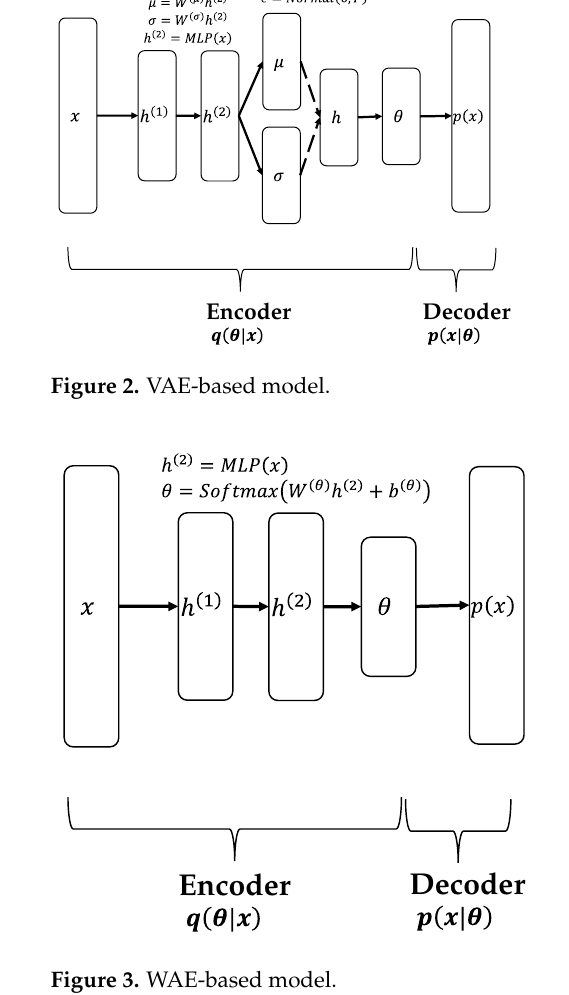
Table 1: Table of Notation used Indices: K